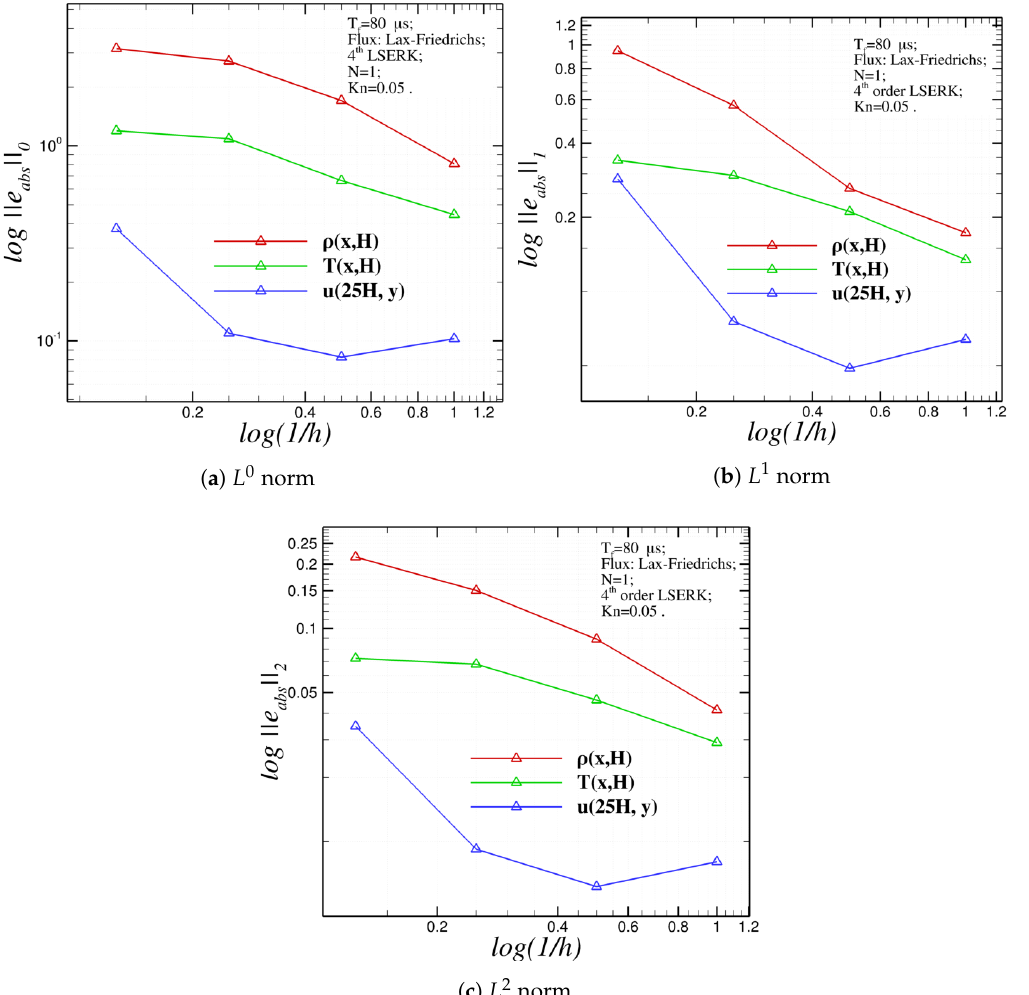
Figure 5. L 0 , L 1 and L 2 norms of the absolute error between the results achieved with DG–FEM and reference data in [21] against the inverse of the dimensionless grid spacing h . Results presented for density and temperature in the centerline of the microchannel and stream wise velocity in the cross section x = 25 H . Results obtained at the final time T f = 80 µ s with Kn =